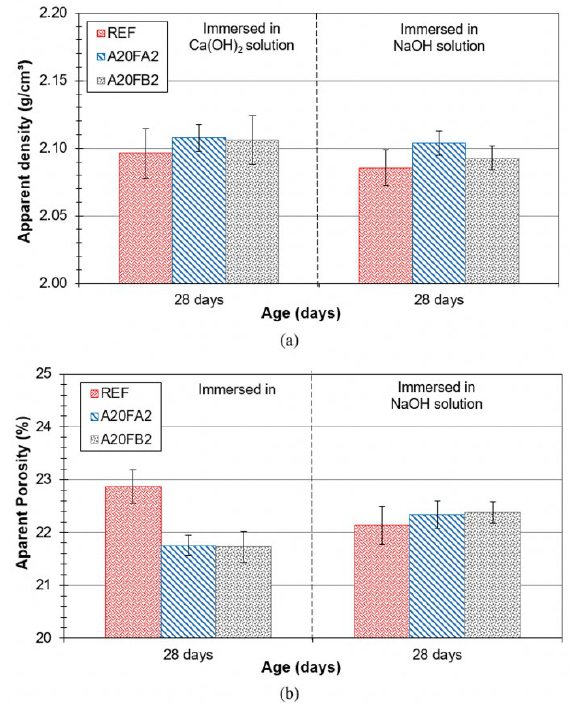
Figure 8. (a) Apparent density and (b) apparent porosity of the reference mortars and containing 20% of the GRF, at 28 days of curing and after 28 days immersed in saturated solution in lime and 28 days immersed in solution of NaOH